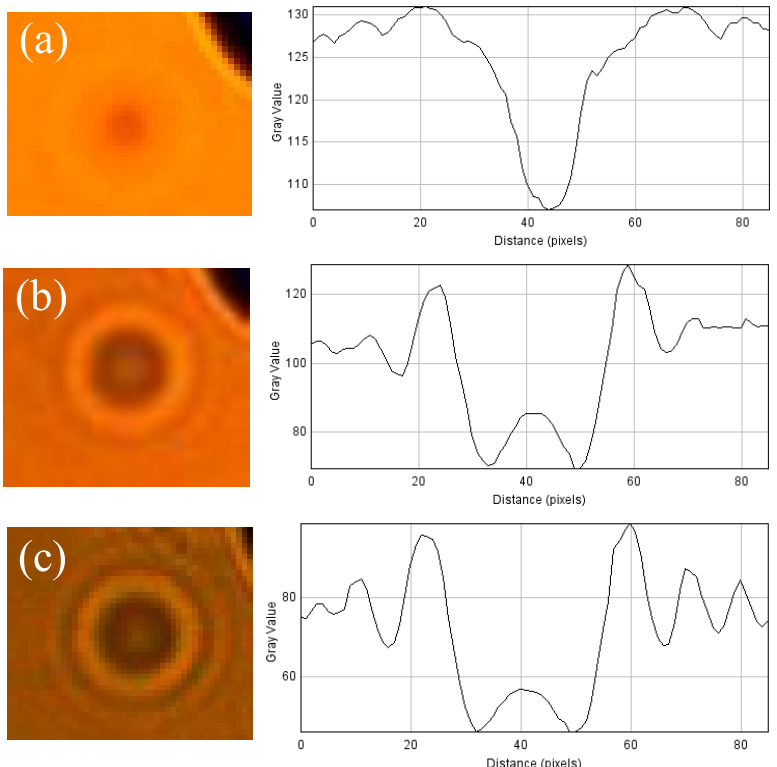
Figure 11. Examples of the different diffraction patterns and their linear intensity profile for different pinholes ( a ) D pinhole = 500 µ m; ( b ) D pinhole = 200 µ m; and ( c ) D pinhole = 50 µ m all of them with Z 1 = 11 mm and Z 2 = 1 mm.